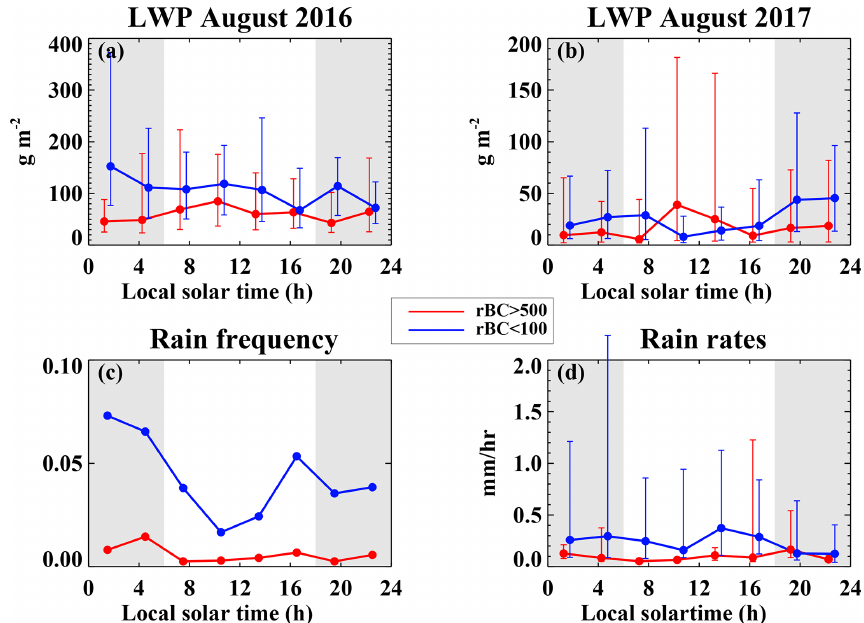
Figure 7. Diurnal cycle of liquid water paths at the airport for (a) August 2016 and (b) August 2017, composited by “more” (red) versus “less” (blue) smoky days, shown as the median values (filled circles) and interquartile range (vertical bars) of 1min cloud LWP values > 0. Note the change in y axis range between (a) and (b) . (c) Diurnal cycle of 3-hourly disdrometer-derived rain frequencies, 2016 and 2017 combined. (d) Diurnal cycle in the median rain rates and their interquartile range at the AMF1 site, similarly composited for 2016 and 2017 combined. Only 1min samples with rain rates exceeding 0mmh − 1 are included. The data are aggregated every 3h (00:00–03:00, 03:00– 06:00, 06:00–09:00, 09:00–12:00, 12:00–15:00, 15:00–18:00, 18:00–21:00, 21:00–24:00LST) with values indicated approximately at their midpoint in time. Gray shadings indicate night